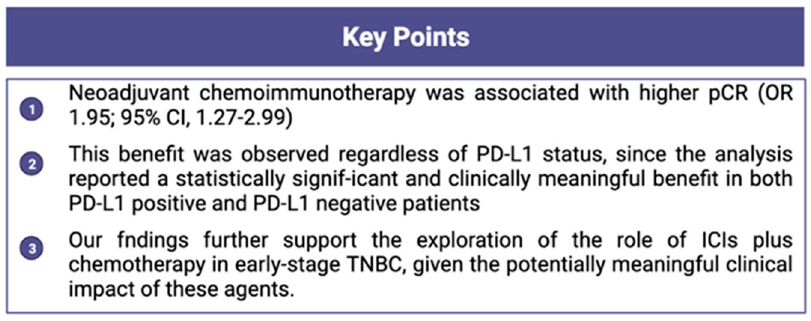
Figure 6. Key points of the current meta-analysis.